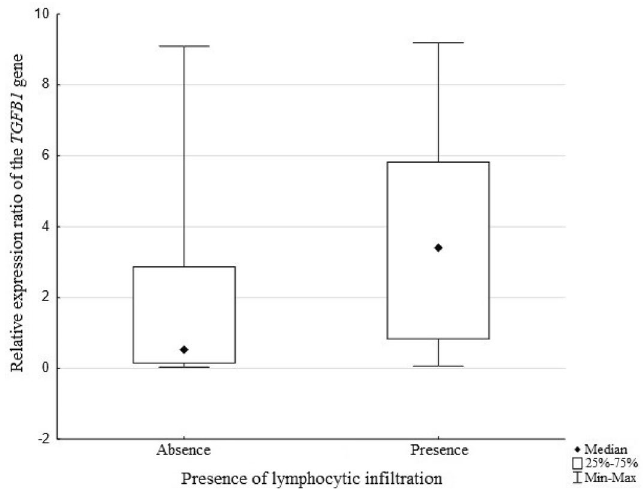
Figure 5. Relative expression levels of the TGFB1 gene and presence of lymphocytic infiltration in the tumor